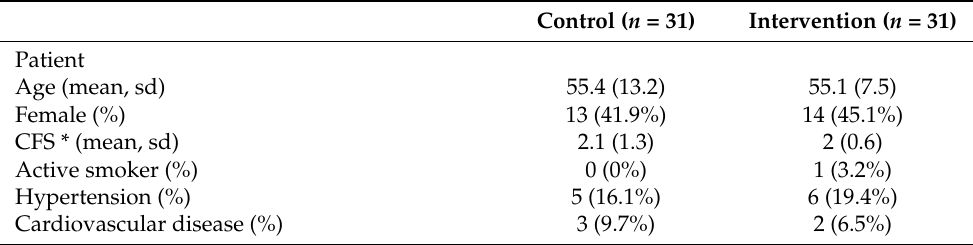
Figure 1. Flowchart of study inclusion. GP—general practitioner. Table 1. Cohort description.